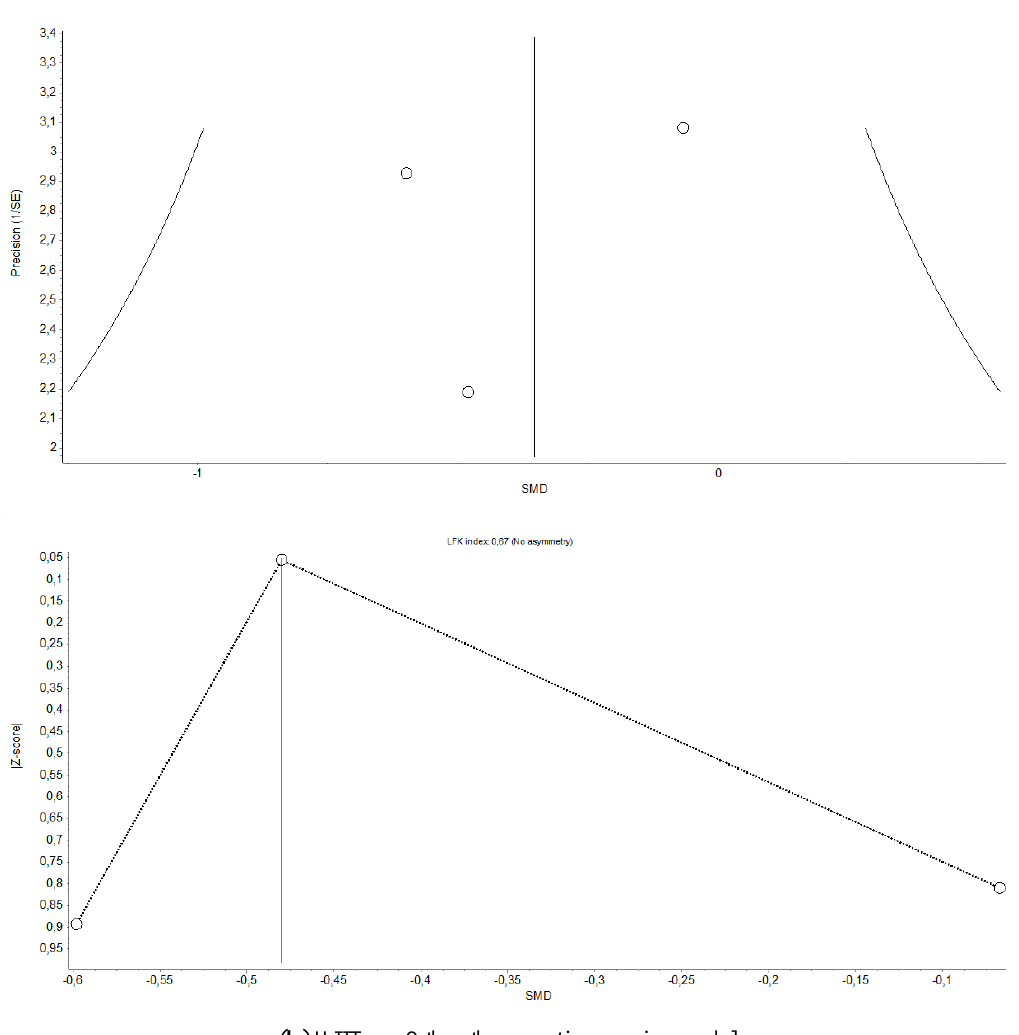
Figure A1. Synthesis funnel and Doi plot (LFK index) for pain intensity to assess the presence of publication bias.